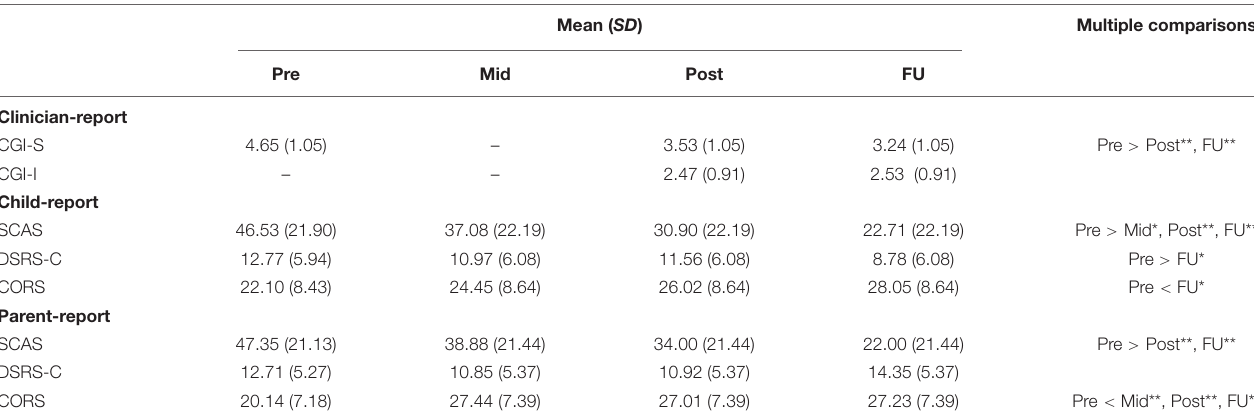
TABLE 4 | Effect sizes of outcomes (Hedges’ g , 95% CI).